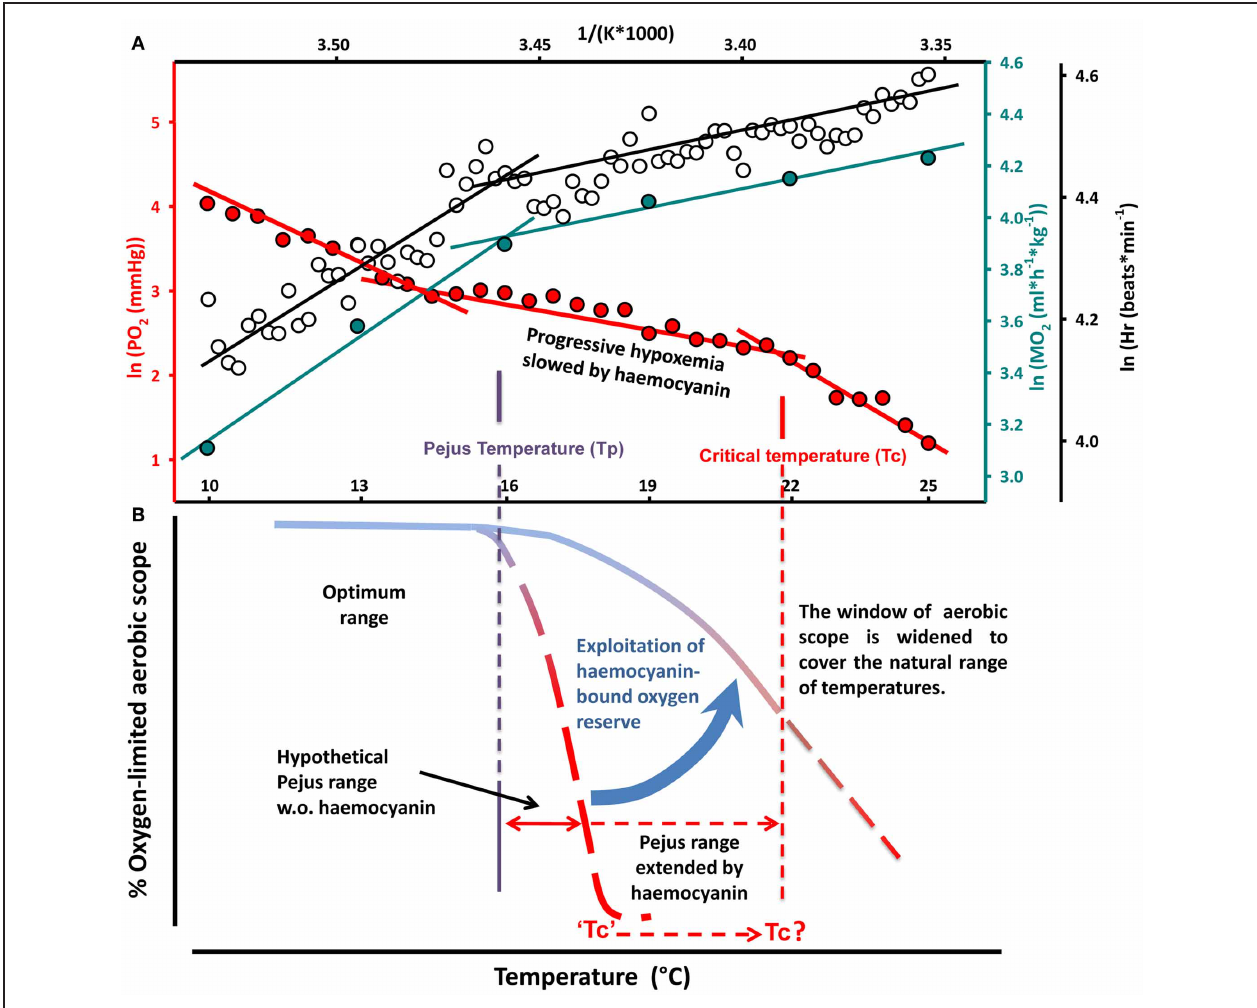
FIGURE 8 | Conceptual model of the role of haemolymph oxygen capacity in the thermal tolerance of a eurythermal crab. (A) Arrhenius plot of the temperature dependent changes in oxygen consumption, heart rate and venous P O 2 reveal breakpoints identified as pejus temperature (Tp, left) and critical temperature (Tc, right). (B) In aquatic ectotherms acute warming beyond the optimal range causes a progressive mismatch between oxygen supply and demand, thereby limiting aerobic scope and associated functional capacity and